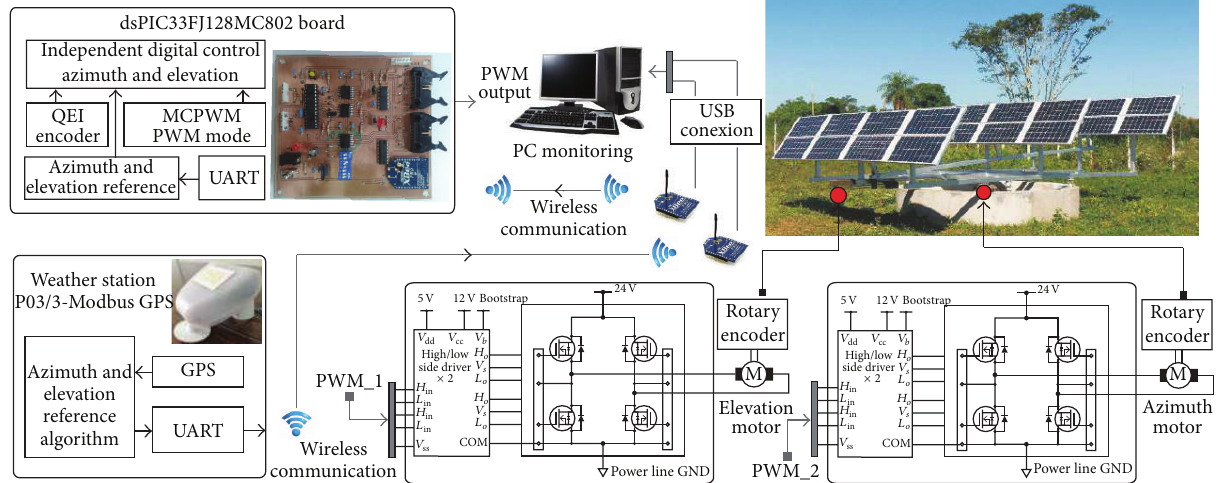
Figure 1: Block diagram of the proposed biaxial solar tracking system based on